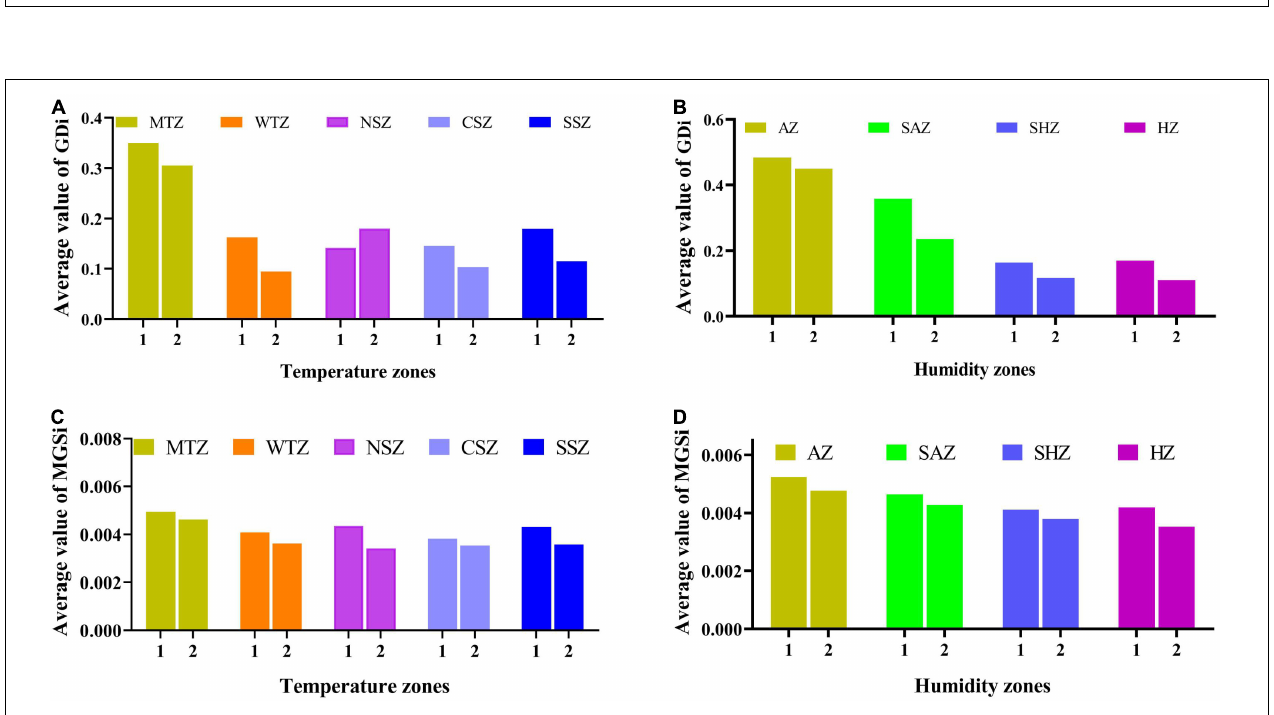
FIGURE 3 | Spatial variations in the VG of the 439 cities. (A) Distribution of the VG pixels in the 439 cities; (B) spatial distribution of greening area of the VG; (C) spatial distribution of the GDi; (D) spatial distribution of the GDDi; and (E) spatial distribution of the MGSi. Dots in the images represent the selected cities; colors refer to the category of the greening area, GDi, GDDi, and MGSi. The histograms show the distribution of the values of the greening area, GDi, GDDi, and MGSi.